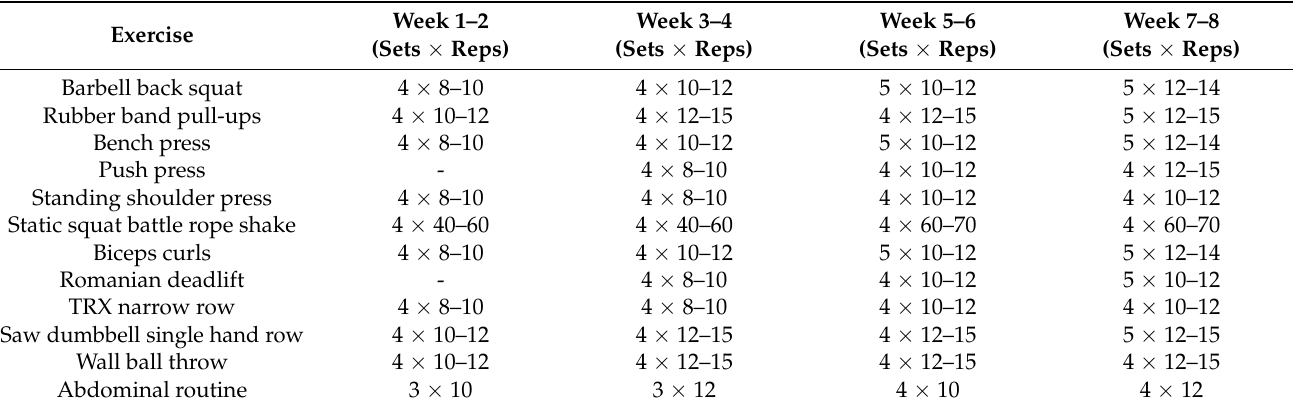
Table 2. Eight-week resistance training